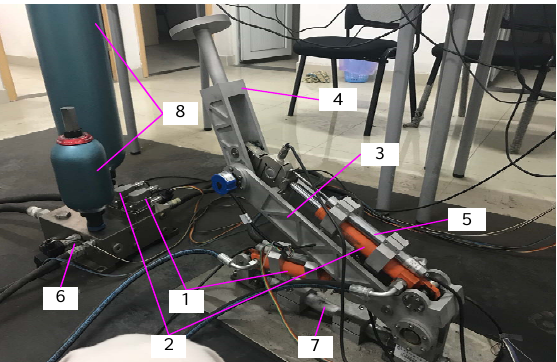
Figure 9. The experimental bench construction of the MEHAs with two EHA nodes: 1—node 1 (servo valve 1 and hydraulic cylinder 1); 2—node 2 (servo valve 2 and hydraulic cylinder 2); 3—robotic upper arm; 4—robotic forearm; 5—displacement transducer; 6—pressure transducer; 7—bench torso; 8—accumulator.